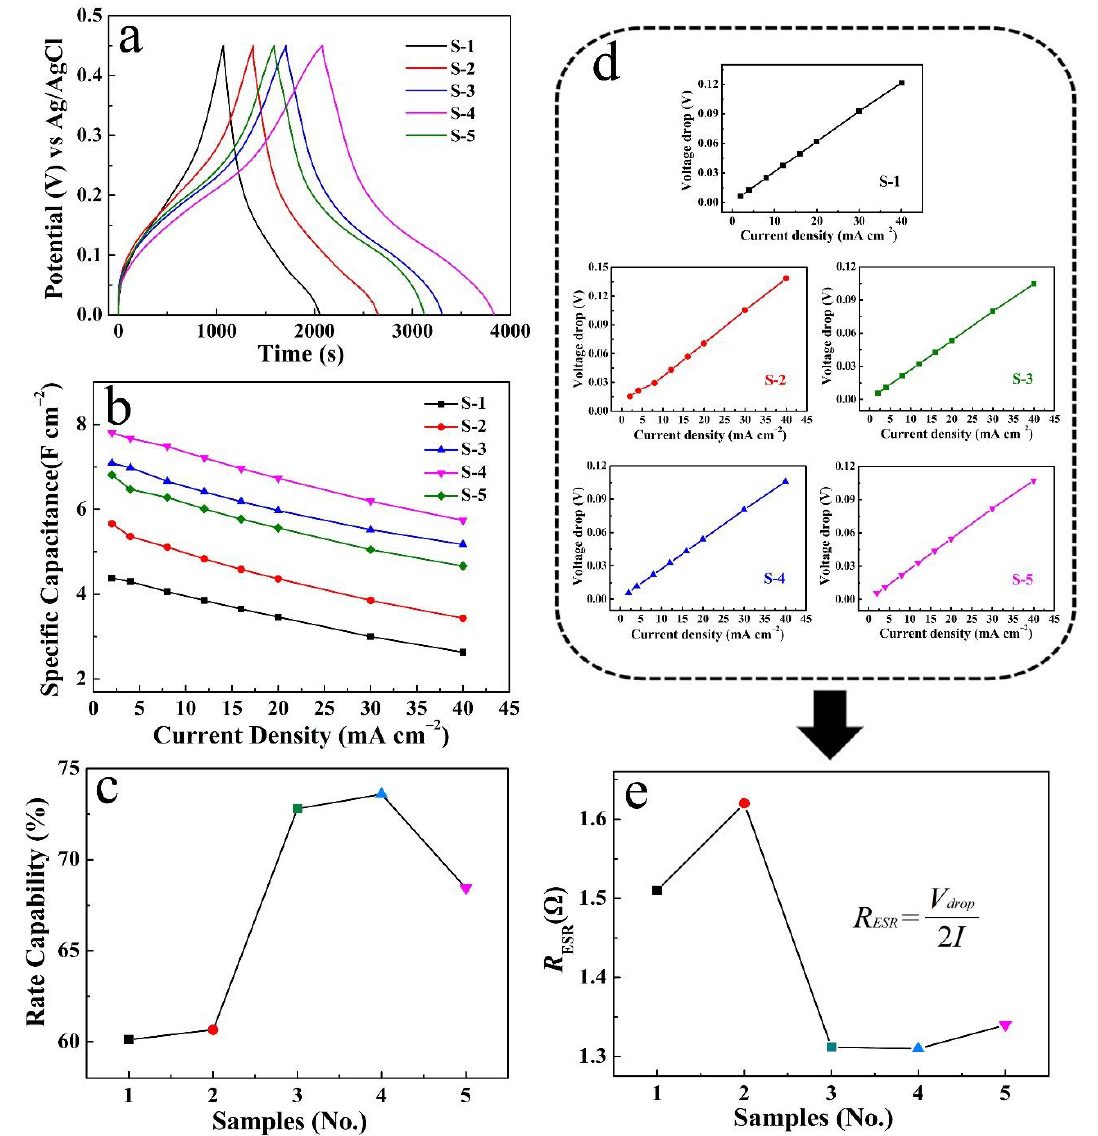
Figure 6. Performances comparison of S-1, 2, 3, 4 and 5: ( a ) GCD curves at different current densities, ( b ) corresponding C s and rate capability ( c ), ( d ) voltage drops and corresponding average R ESR ( e ).